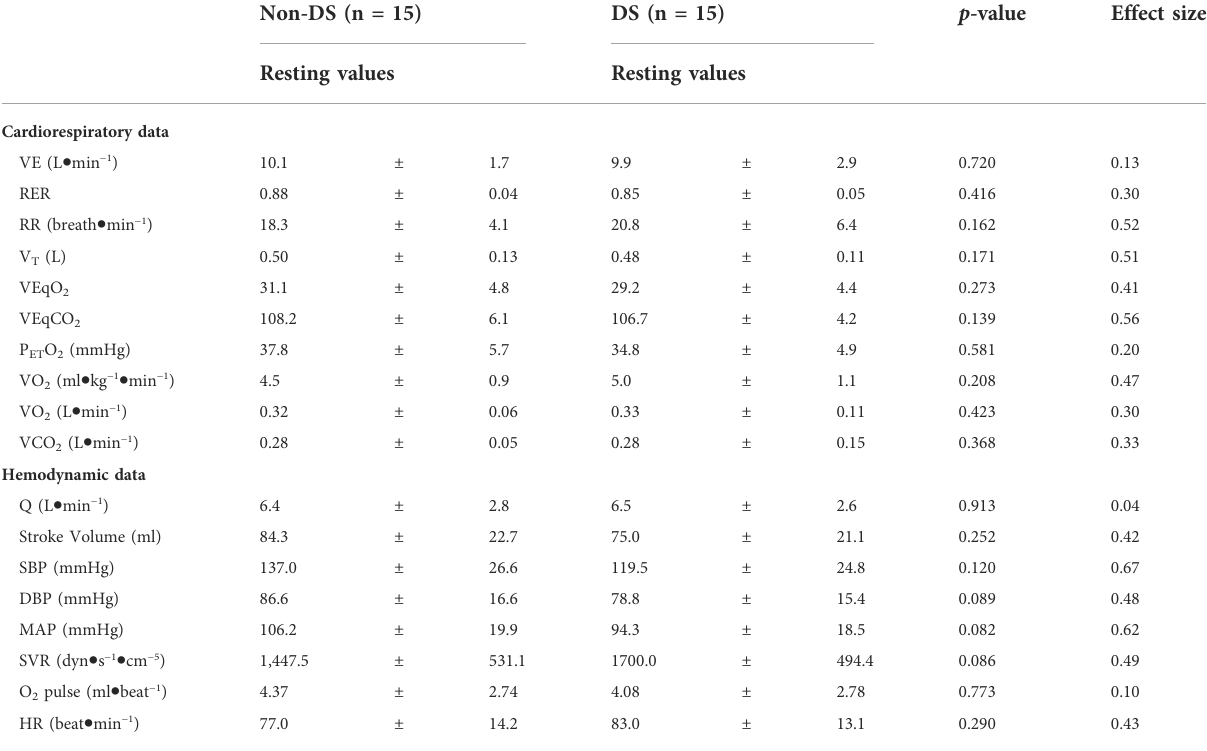
TABLE 2 Participants ’ cardiorespiratory and hemodynamic values at